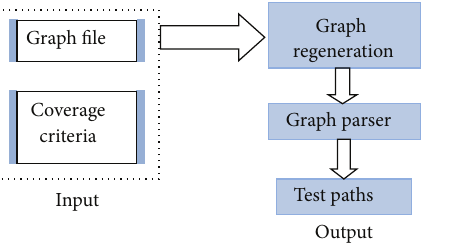
Figure 8: Test path generator tool process.